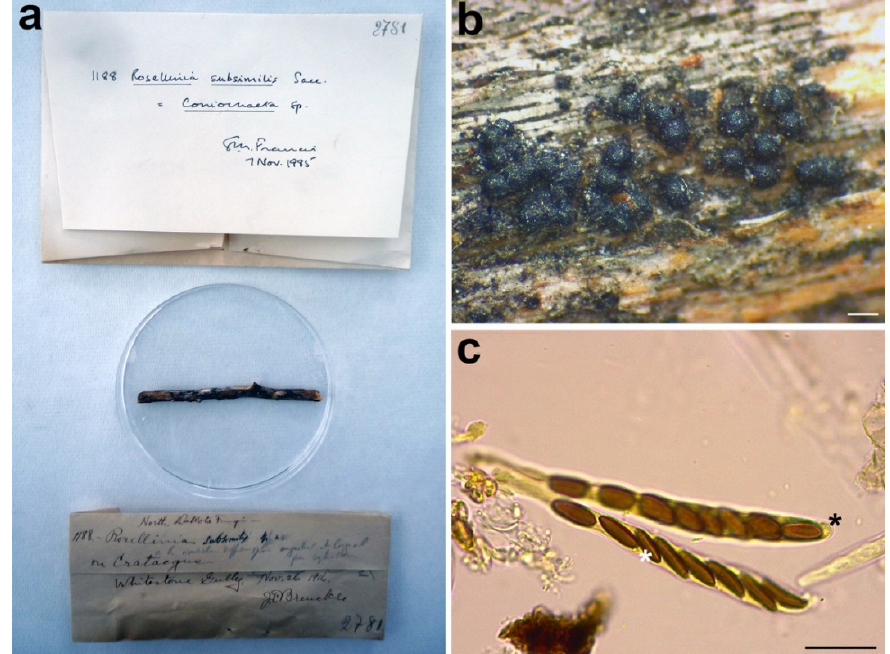
Figure 12. Rosellinia subsimilis . ( a ) Original fungarium specimen. ( b ) Perithecia on natural substrate. ( c ) Asci without amyloid apical apparatus (black asterisk); ascospores showing germ slit (white asterisk). Bars: ( b ) = 200 μ m; ( c ) = 20 μ m.